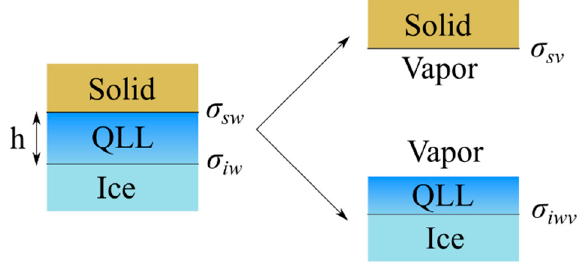
Figure 4. The scheme of the process for ice-solid contact separation in the presence of a quasi-liquid layer (QLL) on the ice surface.